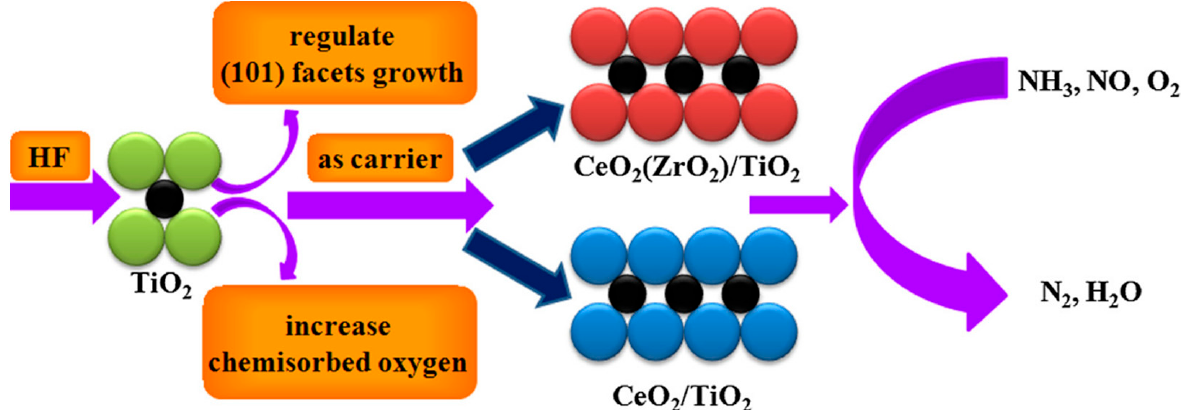
Figure 27. Influence mechanism of HF on CeO 2 (ZrO 2 )/TiO 2 catalysts [99].